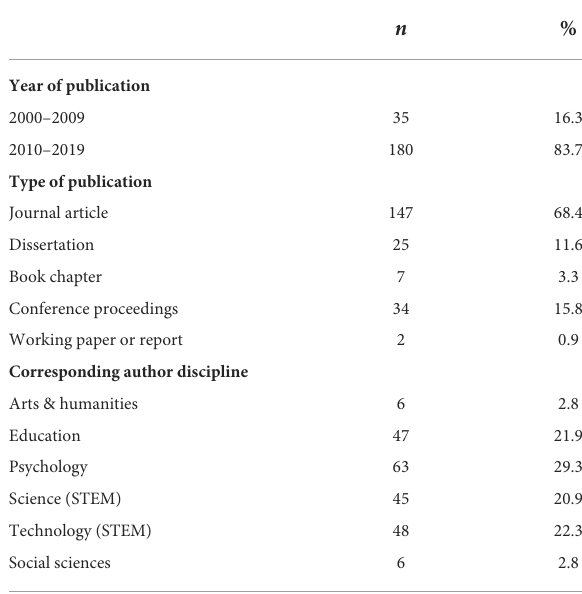
TABLE 3 Characteristics of the publications. TABLE 4 Characteristics of the